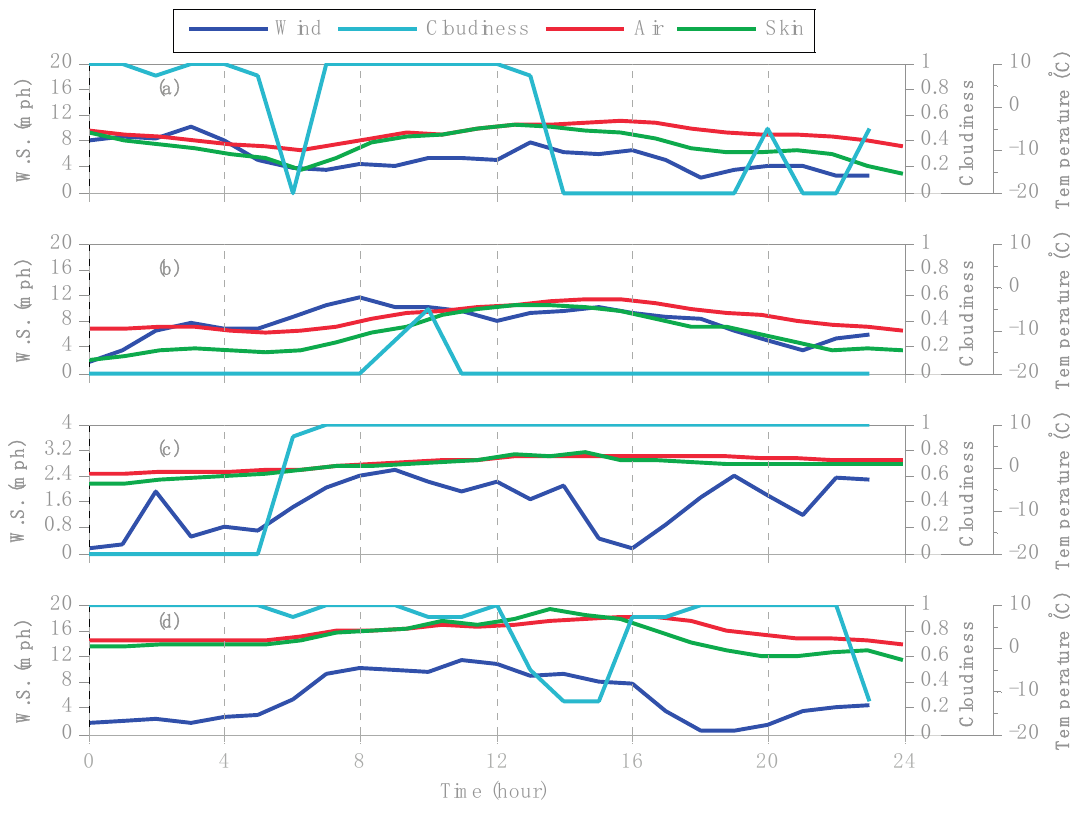
Figure 11. Snow surface and near-surface air temperature hourly values at the CREST-SAFE station in Caribou, ME for the days of 15–16 March ( a , b ) and 9–10 April ( c , d ) of winter